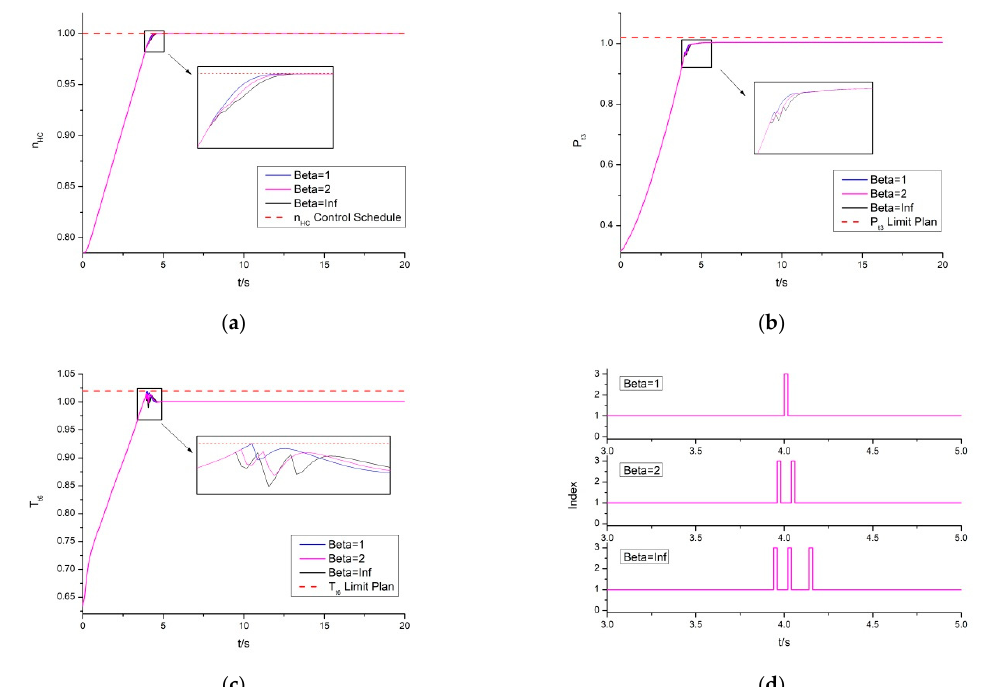
Figure 15. Simulation results of the acceleration control with different β Tt 6 : ( a ) Corrected high-pressure rotor speed response; ( b ) High-pressure compressor outlet total pressure response; ( c ) Mixing chamber inlet total temperature response; ( d ) Controller index.